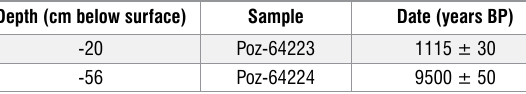
New accelerator mass spectrometry uncalibrated dates taken from the sampled section Depth (cm below